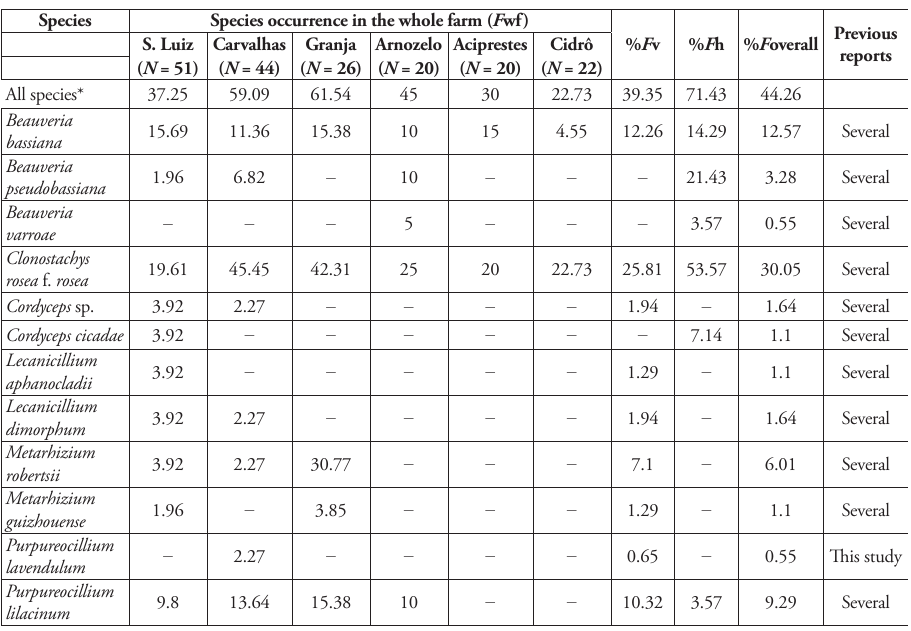
Table 1. Occurrence frequency (% of positive samples) of entomopathogenic fungi Douro vineyards’ soils and adjacent